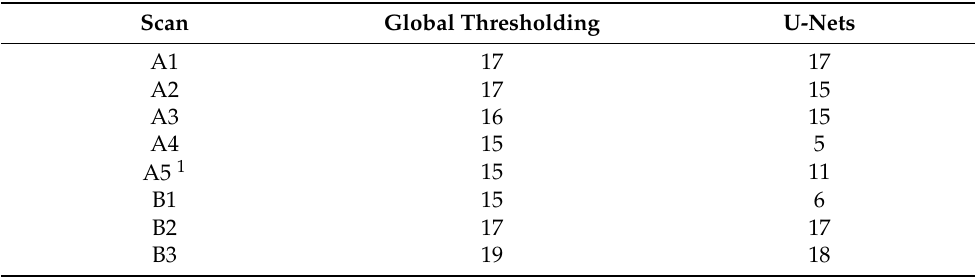
Table 2. Number of apparent contacts detected on top (non-contacting) labelled subvolume before local refinements, for each segmentation